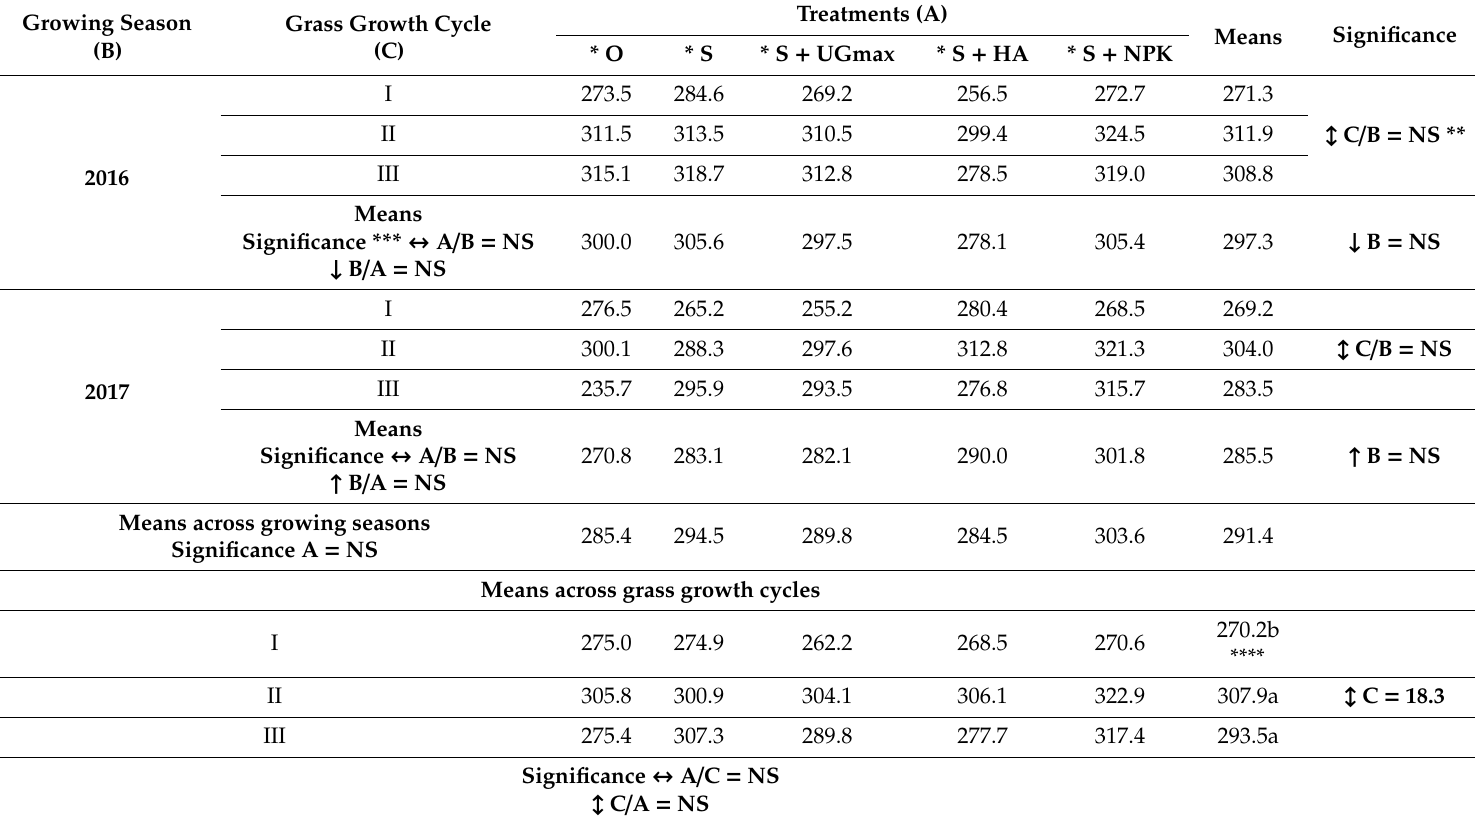
Table 3. The e ff ect of treatments on mean crude fiber content in Festulolium braunii dry matter across grass growth cycles and growing seasons (g · kg − 1 ). Growing Season